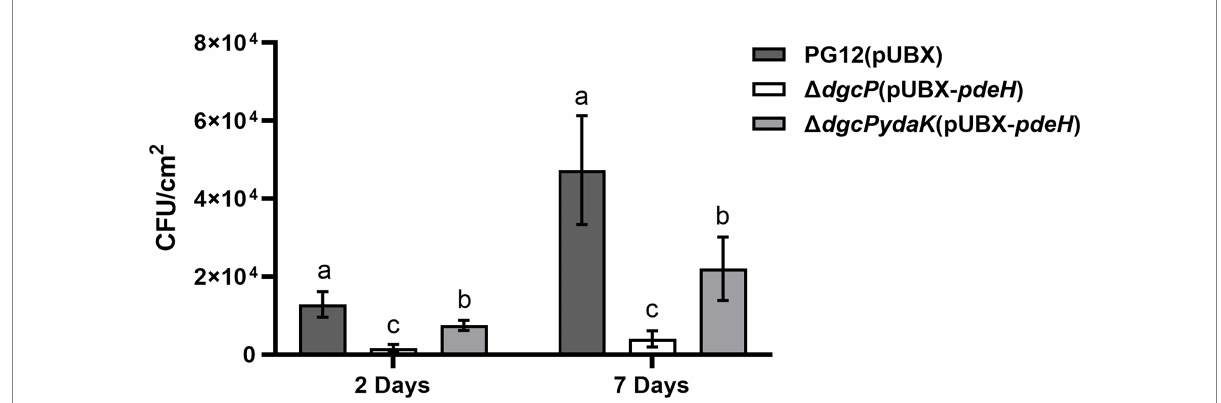
FIGURE 11 Bacterial population re-isolated from the surface of apple fruits treated with B. velezensis PG12(pUBX), Δ dgcP (pUBX- pdeH ), or Δ dgcPydaK (pUBX- pdeH ). Bacteria were incubated for 48 h in LB medium supplemented with 1% (w/v) xylose at the final concentration. Fuji apple fruits were soaked in the culture with 2.5 × 10 8 cells/ml of B. velezensis PG12(pUBX) [PG12(pUBX)], Δ dgcP (pUBX- pdeH ), or Δ dgcPydaK (pUBX- pdeH ). Bacteria were isolated from the surface of the treated apple fruits at 2 and 7 days post inoculation, respectively. Values correspond to the mean bacterial population from three apple fruits. The data is a representative of two independent experiments. Different letters on the column indicate significant differences between different treatments according to the least significant difference (LSD) test ( p <